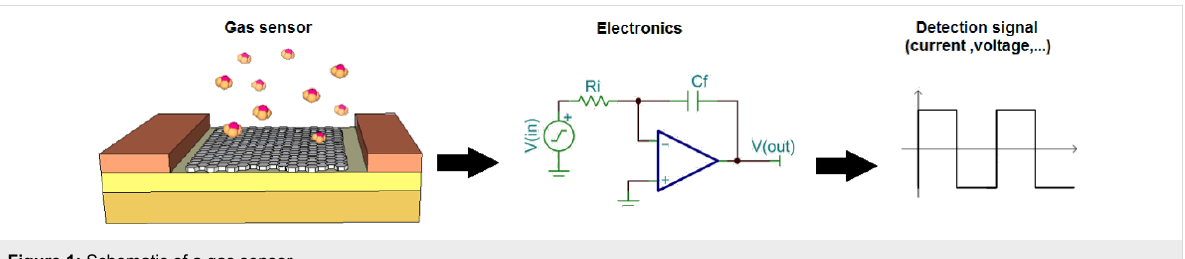
Figure 1: Schematic of a gas